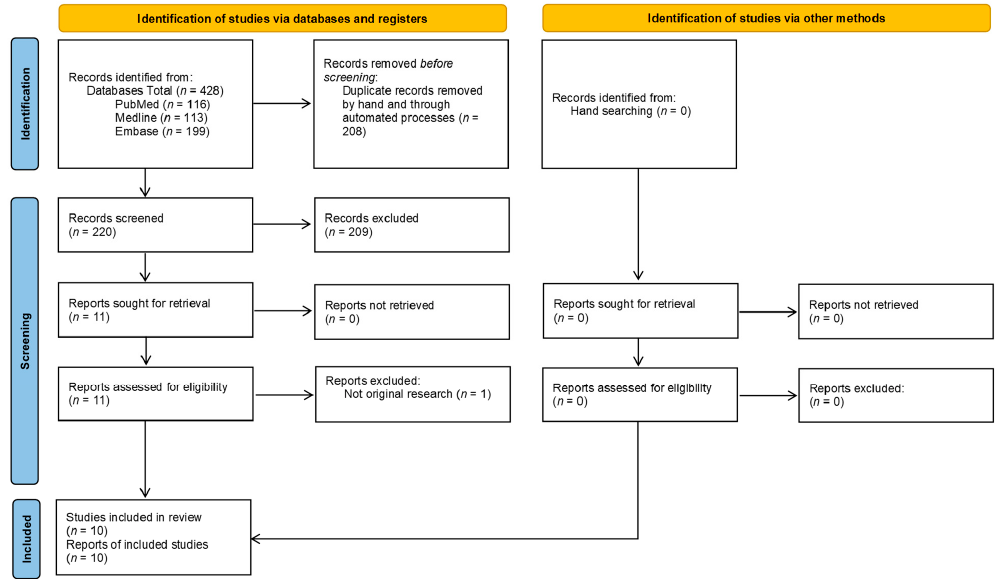
Figure 1. Diagram demonstrating the search strategy used according to the PRISMA protocol